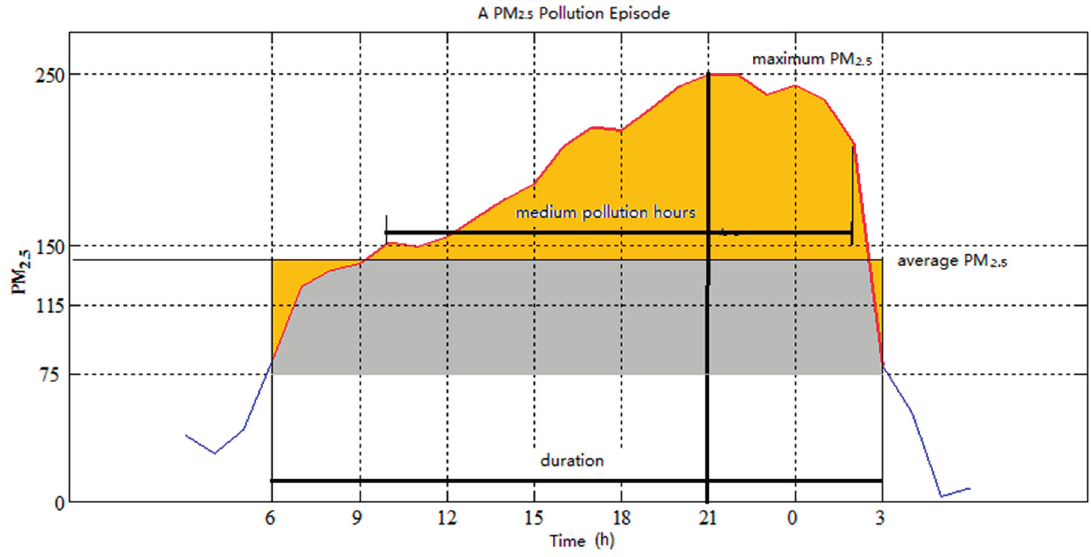
Figure 1 . Definitions of PM 2.5 Pollution Episode.